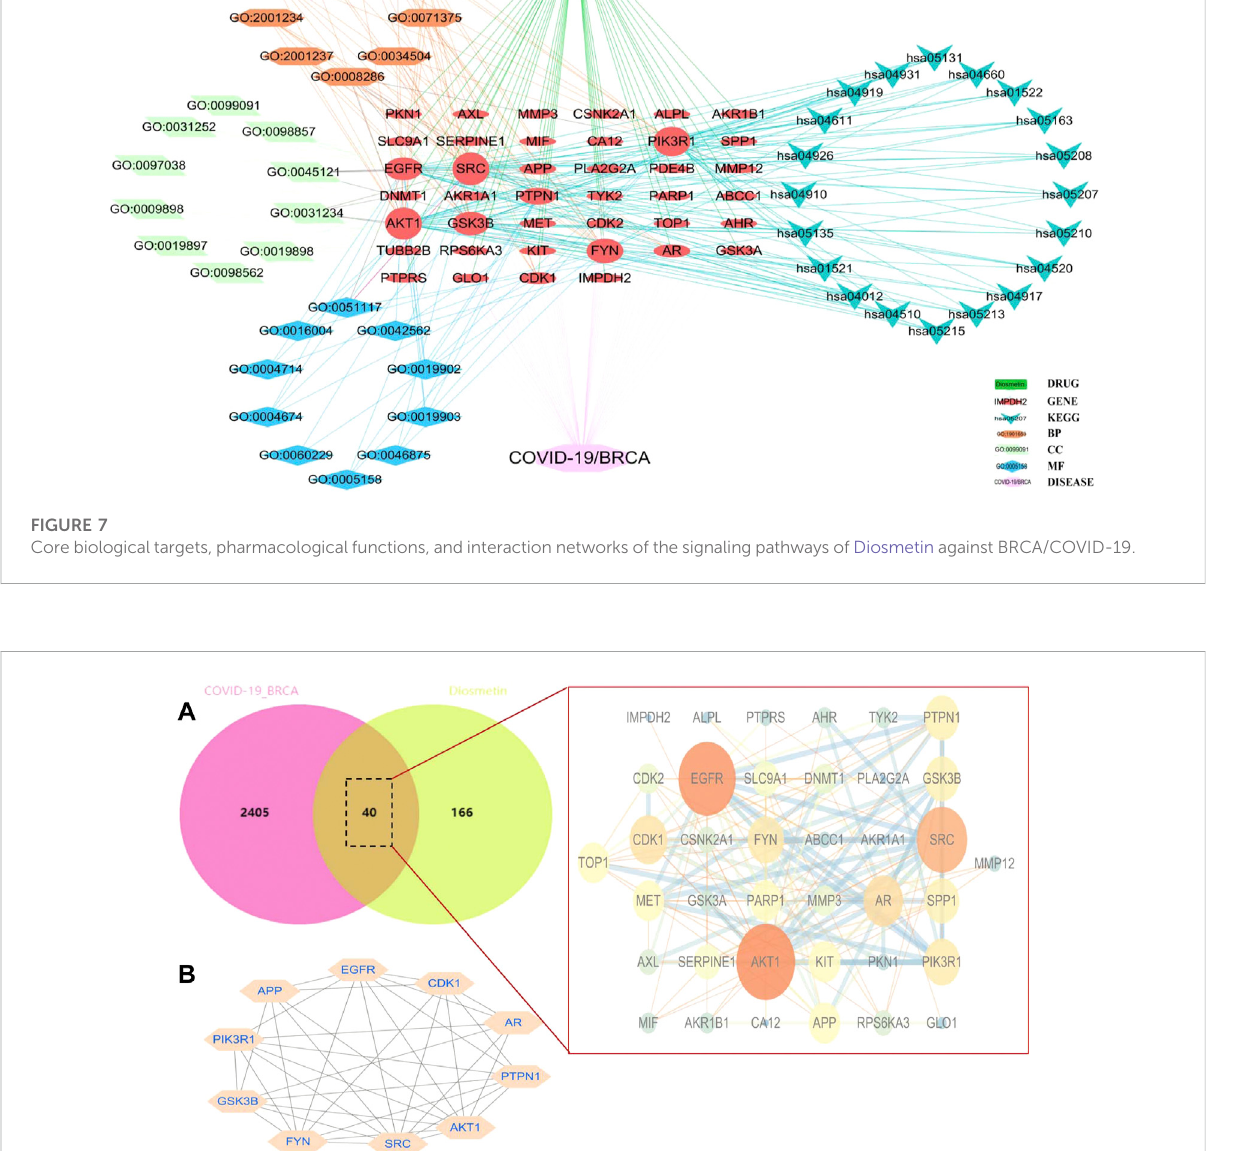
cationic interactions at HIS-296 (5.0 Å), with a π bond (4.8 Å) formed at HIS-296 (Figure 10D), indicating that Diosmetin has a good binding ability of the TMPRSS2 protein (COVID-19). We